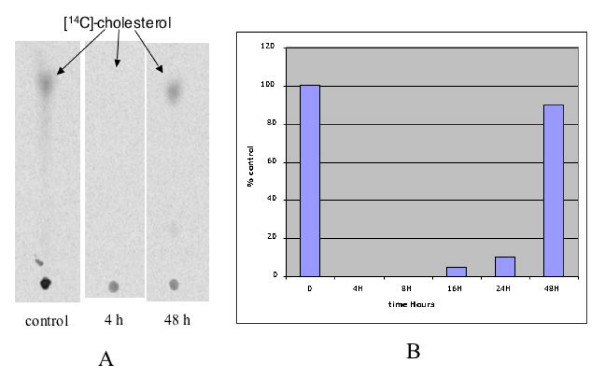
Biosynthesis of [14C]-cholesterol in PC3 cells under ZOL treatments. Cells were treated with ZOL (20 μM) for 2, 22 or 46 hours and [14C]-mevalolactone (2.25 μCi/ml) was added to the medium for 2 hours more. Sterols were separated by thin layer chromatography (silica gel F/ethyl acetate). [14C]-Cholesterol was revealed and quantified by autoradiography with Phophorimager® (Molecular Dynamics).